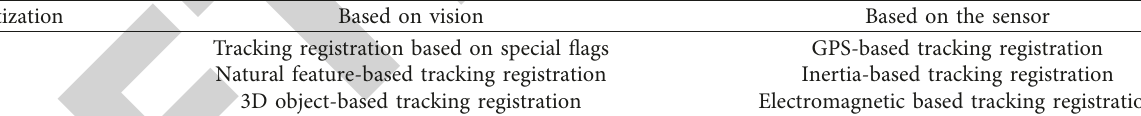
Figure 7: Augmented reality system module composition. Table 1: Augmented reality 3D registration